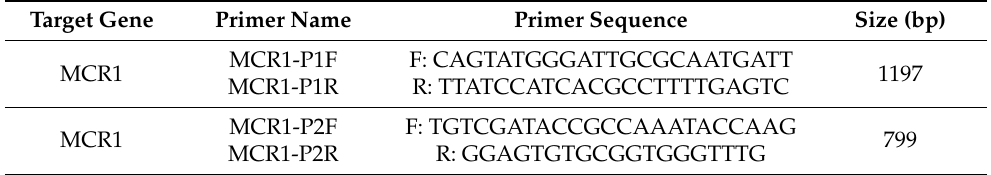
Table 2. Sequences of primers used for the detection of mcr-1 gene in E. coli isolates. Target